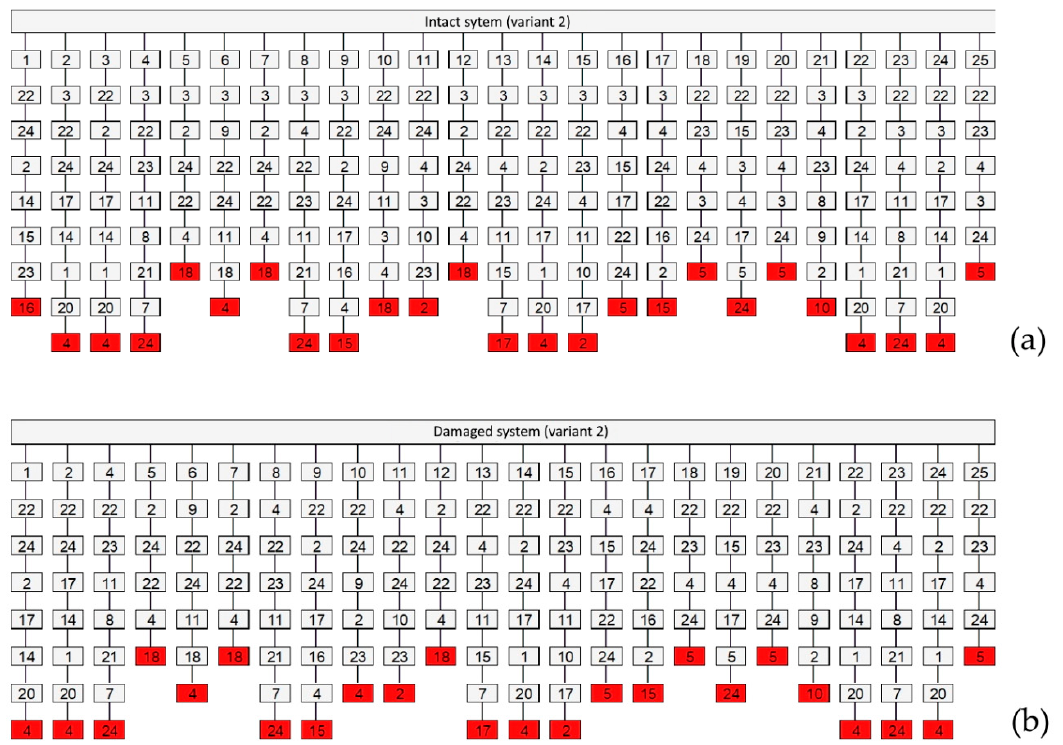
Figure 7. Failure paths of variant 1; intact system ( a ); damaged system after loss of component 25 ( b ).